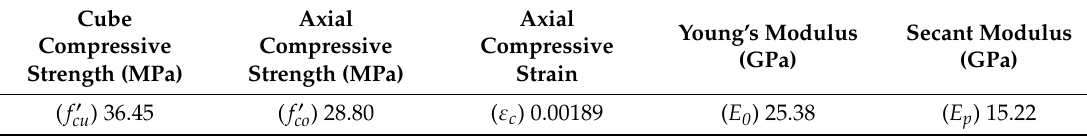
Table 3. Material parameters of